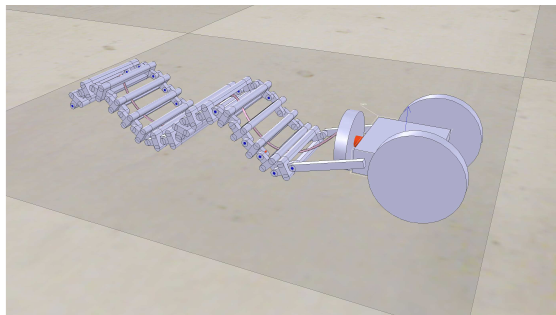
Figure 1. Model of the module dedicated to forward thrust based on undulatory